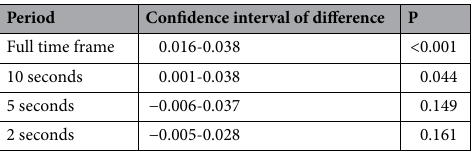
Table 1. Average perfusion indexes (normalized